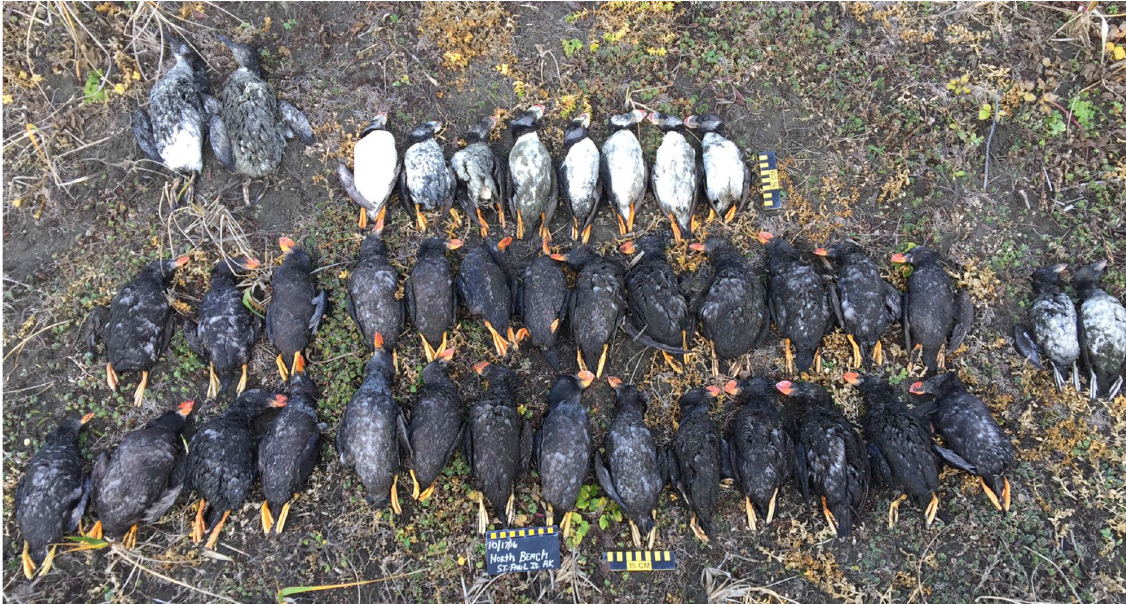
Fig 2. Photo of carcasses found on North Beach, St. Paul Island, Alaska, on 17 October 2016. Birds pictured are 2 murres ( Uria spp.—top row left corner), 8 Horned puffins ( Fratercula corniculata —top row center), 2 juvenile Tufted puffins (middle row right side) and 27 adult Tufted puffins (middle and bottom rows). Scale bar in photo is 15 cm total